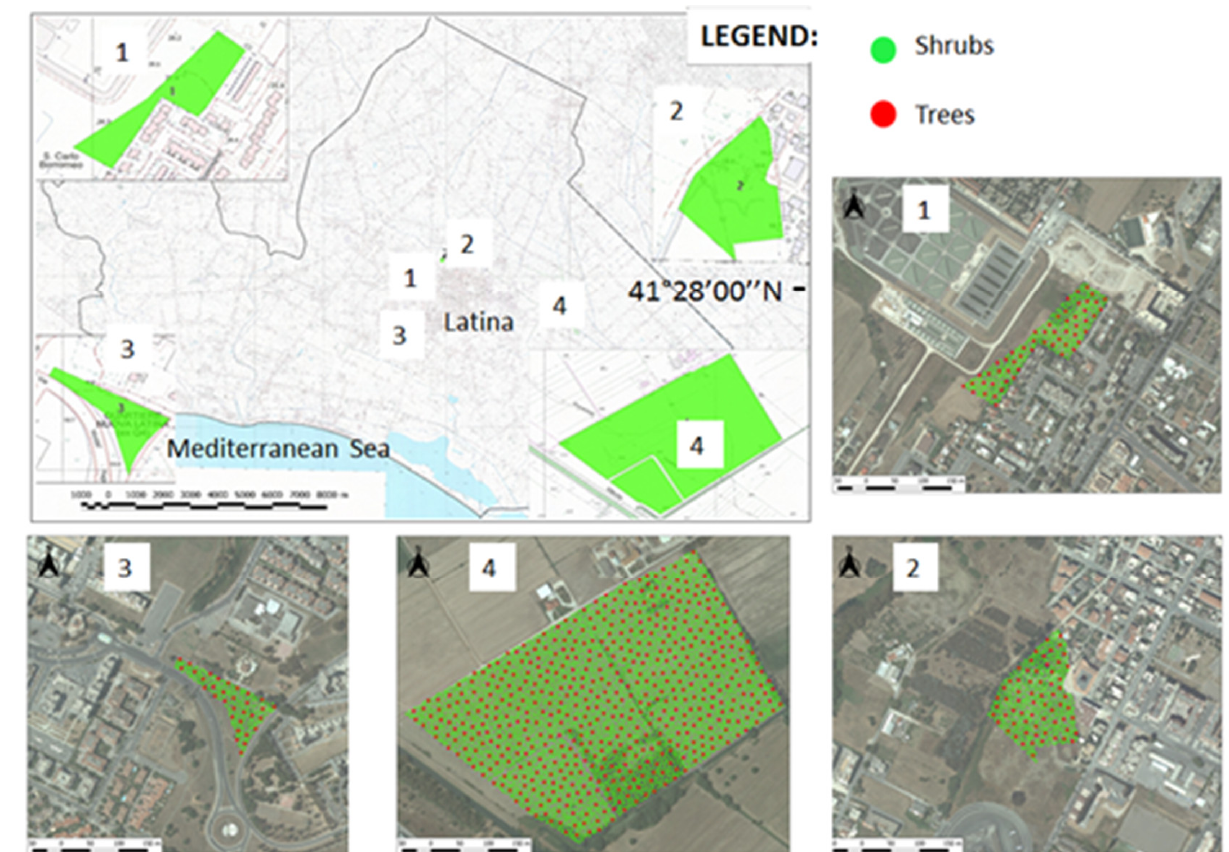
Figure 8. Reforestation project of four abandoned areas. Green points represent shrubs ( Laurus nobilis ) and red points represent trees ( Ulmus minor and Quercus cerris ).